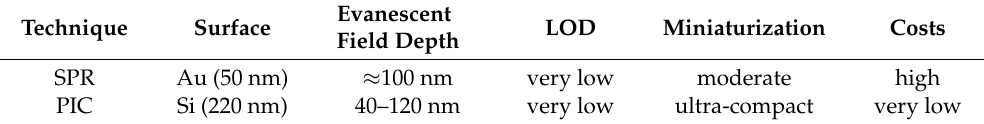
Table 3. Overview of main technology